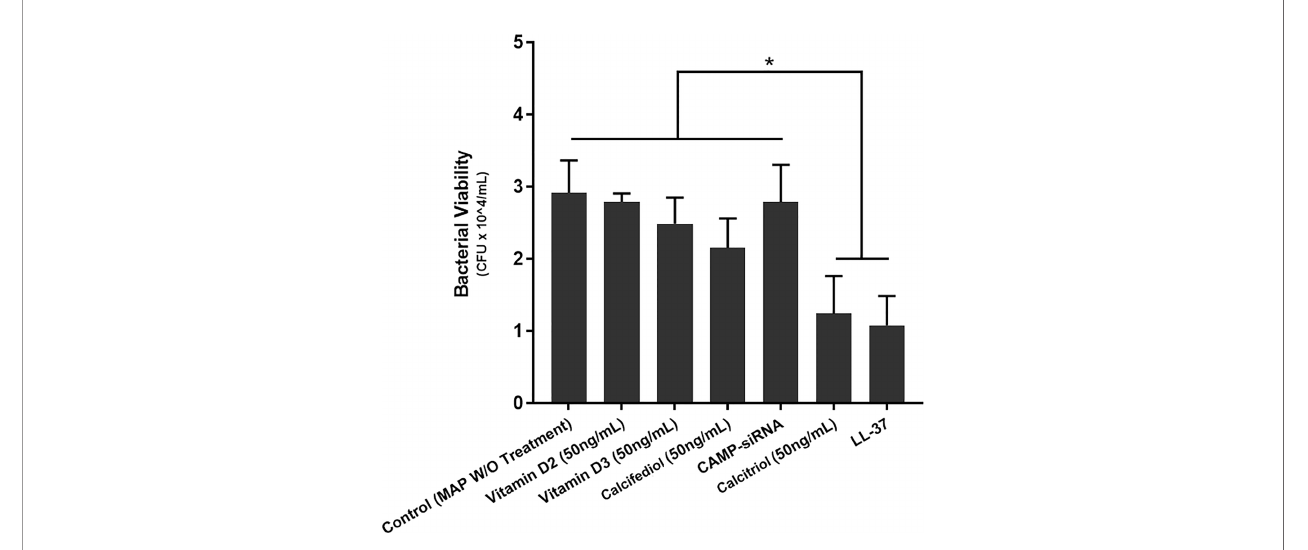
FIGURE 7 | Effects of various vitamin D forms and LL-37 on intracellular MAP Viability in infected macrophages following 24 hours of treatment. Luminescence signal was detected using the GloMax Navigator system (Promega, GM-2000), and bacterial viability was analyzed from the generated luminescence. *Indicates P- value of less than